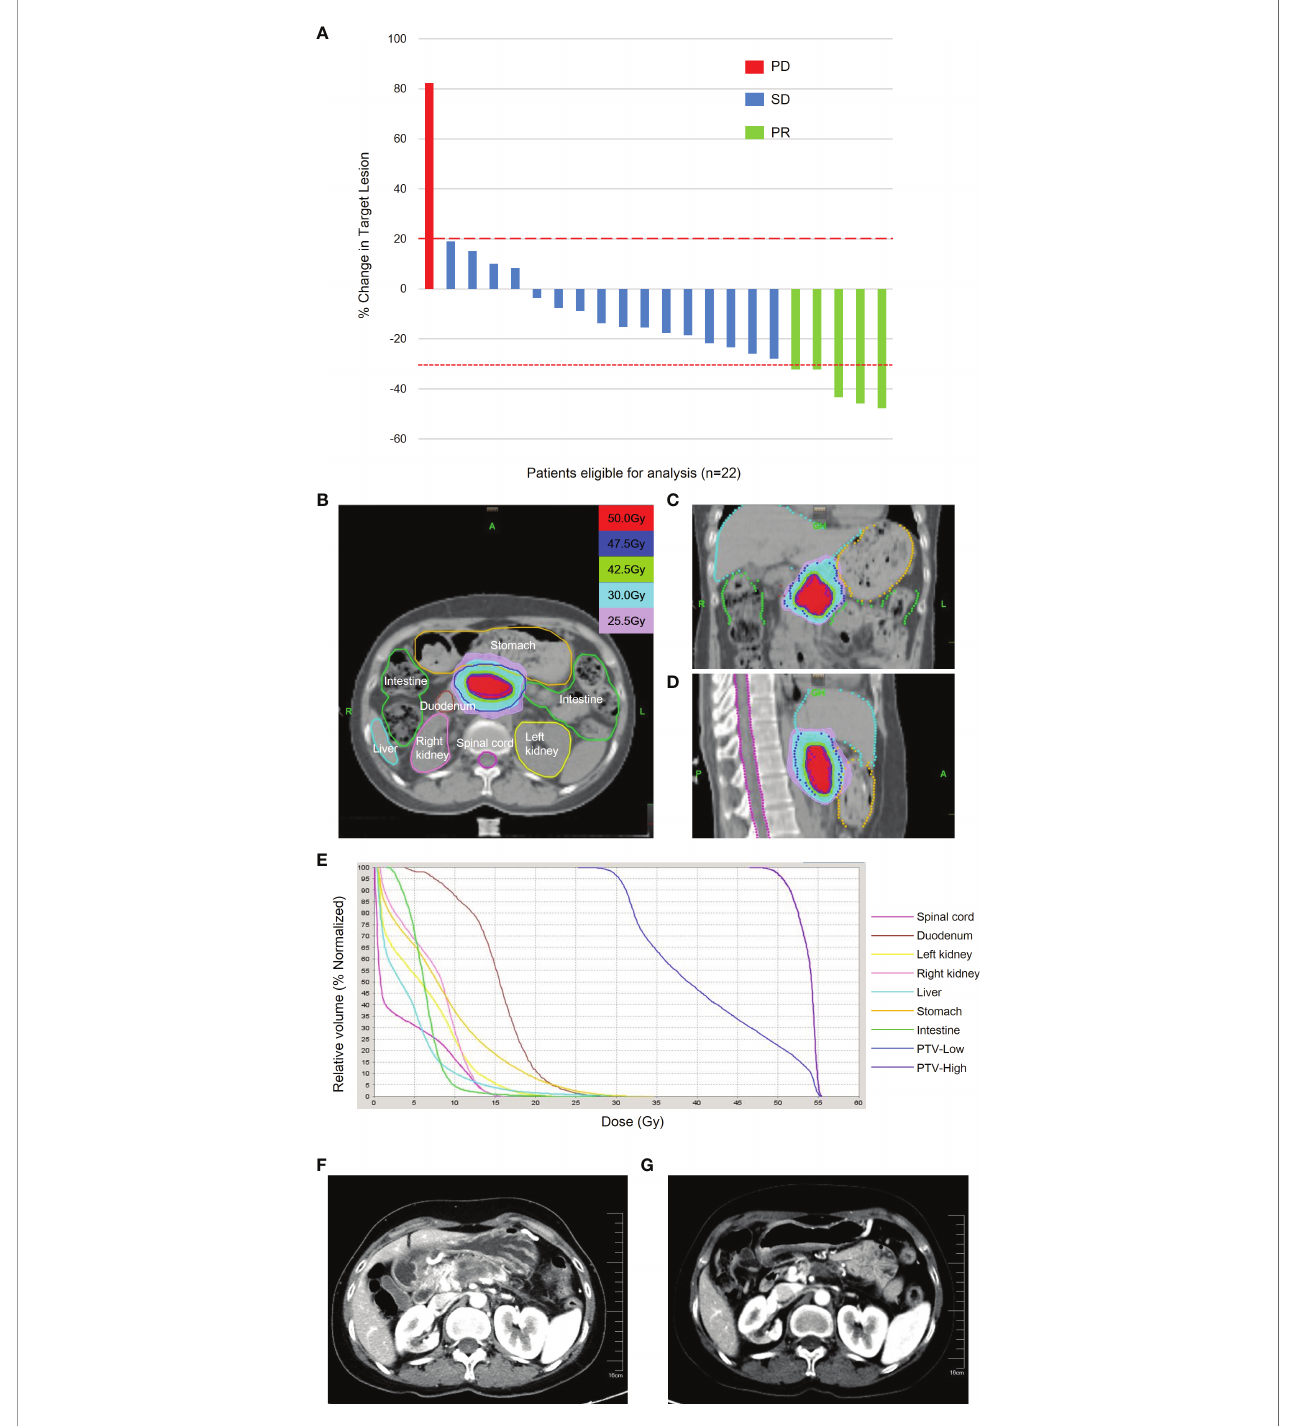
FIGURE 2 | Best treatment responses and representative radiotherapy plan. (A) Best percentage change in tumor size from baseline during treatment. The dashed lines above and below the x-axis represented 20% increase and 30% decrease of target lesions from baseline, respectively. Different color codes represented different tumor response (red, PD; blue, SD; and green, PR). The isodose lines of axial plane (B) , coronal plane (C) , and sagittal plan (D) . Dose-volume histogram (E) was shown. The different doses were represented with different colors. (F) Enhanced CT demonstrated invasion of vessels by tumor before chemoradiotherapy. (G) Enhanced CT revealed the volume of tumors with vessel invasion decreased after chemoradiotherapy. PD, progressive disease; SD, stable disease; PR, partial response; LAPC, locally advanced pancreatic cancer; CT, computed